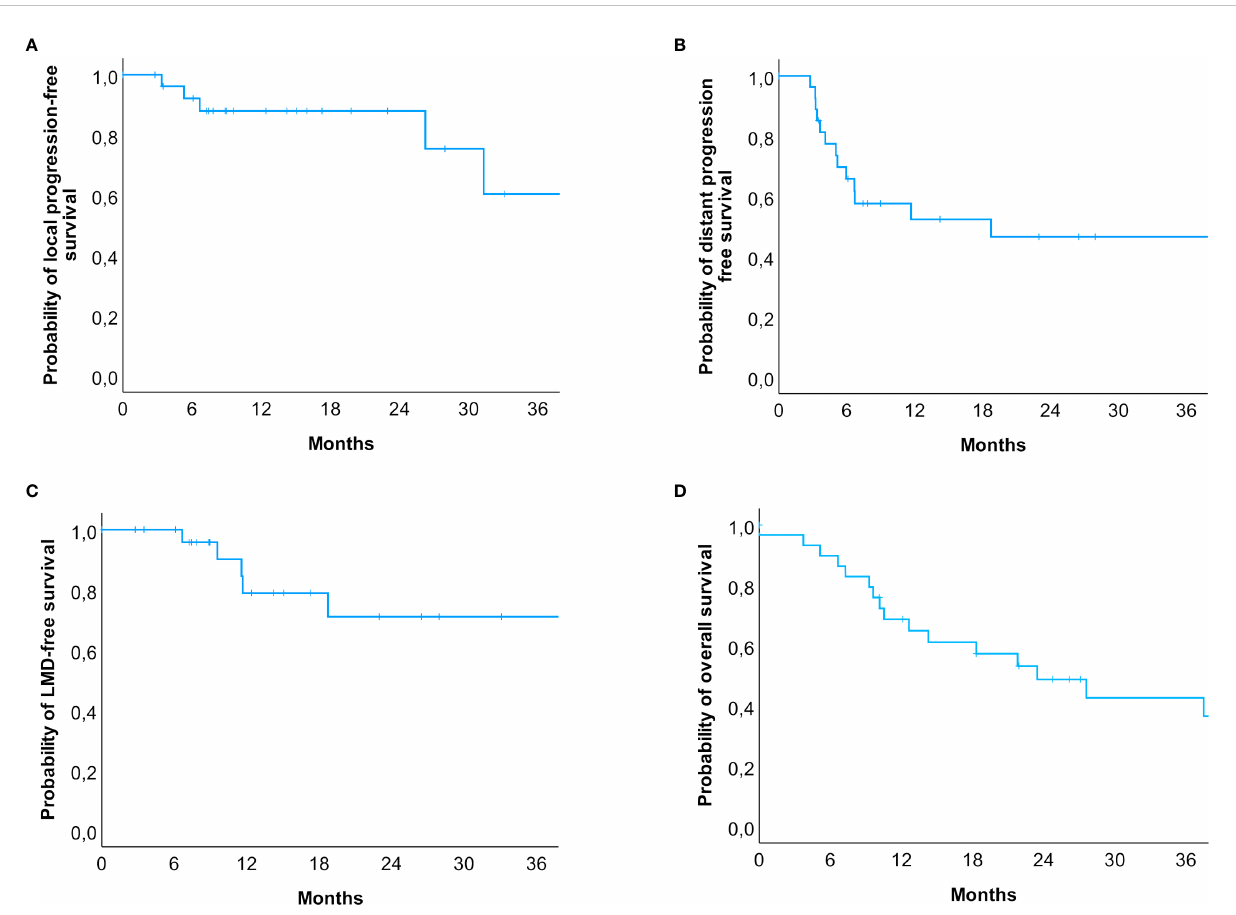
FIGURE 3 Kaplan-Meier-Curves for (A) local progression-free, (B) distant progression-free, (C) leptomeningeal disease-free survival and (D) overall survival. (A) Patients at risk were n = 30 (0 months), n = 23 (6 months), n = 15 (12 months), n = 7 (24 months), and n = 3 (36 months). (B) Patients at risk were n = 30 (0 months), n = 17 (6 months), n = 10 (12 months), n = 6 (24 months), and n = 4 (36 months). (C) Patients at risk were n = 30 (0 months), n = 25 (6 months), n = 14 (12 months), n = 7 (24 months), and n = 4 (36 months). (D) The estimated median survival of our patients was 23.4 months (95% CI: 11.3 – 35.6). Patients at risk were n = 30 (0 months), n = 19 (12 months), n = 11 (24 months), n = 7 (36 months). In total, 14 events occurred within 24 months after the radiosurgical treatment, but only 4 events in the subsequent years were